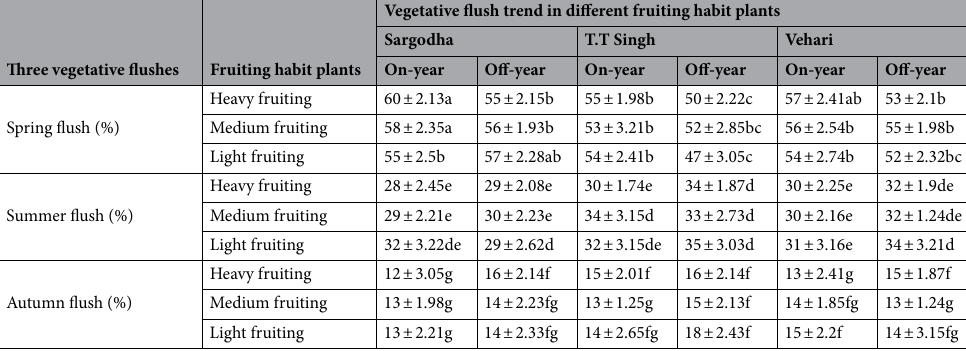
Table 5. Three vegetative flushes trend in different fruiting habits plants during on- & off-years. Results are shown in means (± SD) and sharing different letters are significantly differed to each other according to LSD test (P ≤